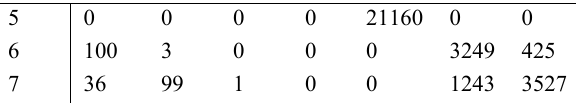
Table 3.1 Error matrix (pixel count) 2016 year